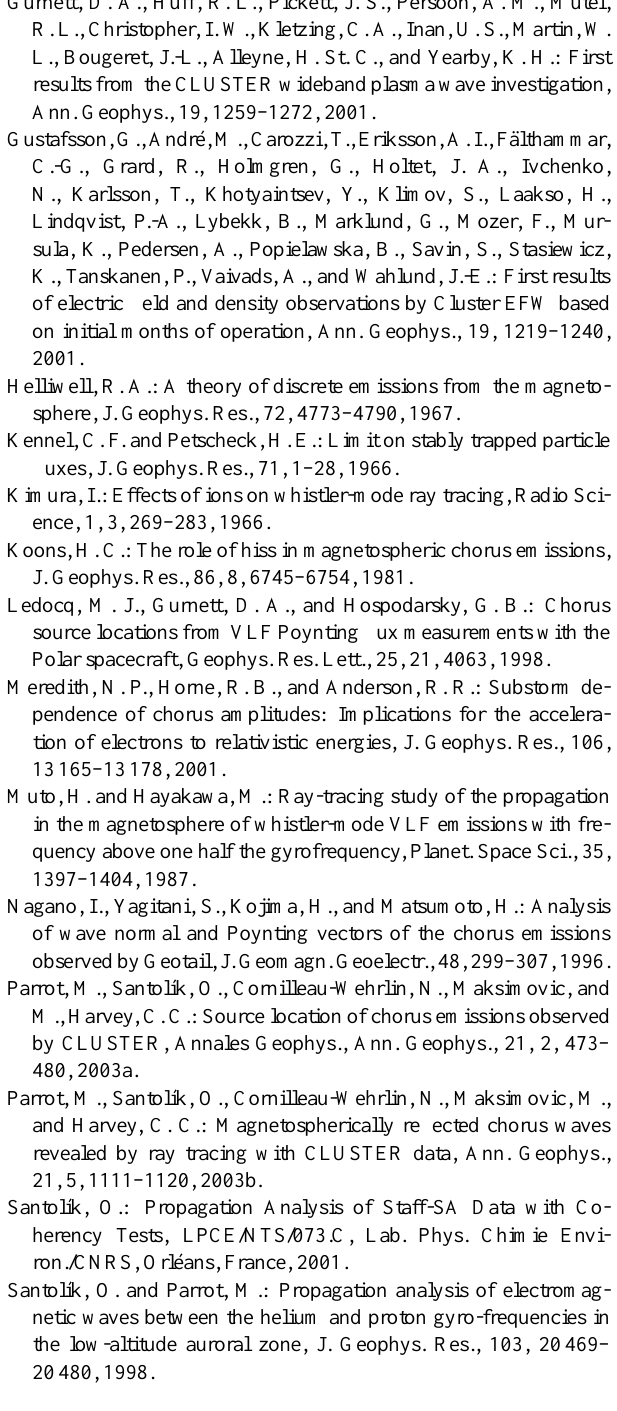
STAFF team: First results obtained by the Cluster STAFF